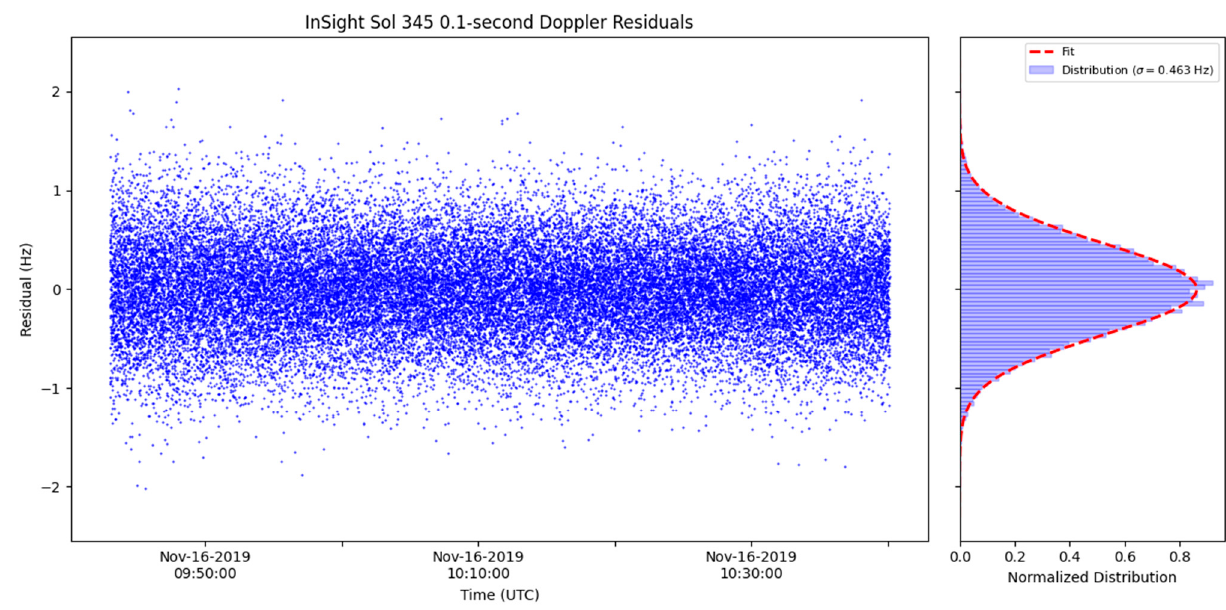
Figure 2. Doppler residuals at 0.1 s count-time for Sol 345 ( left ), and histogram distribution of the residuals ( right ). The standard deviation of the residuals is 0.463 Hz.